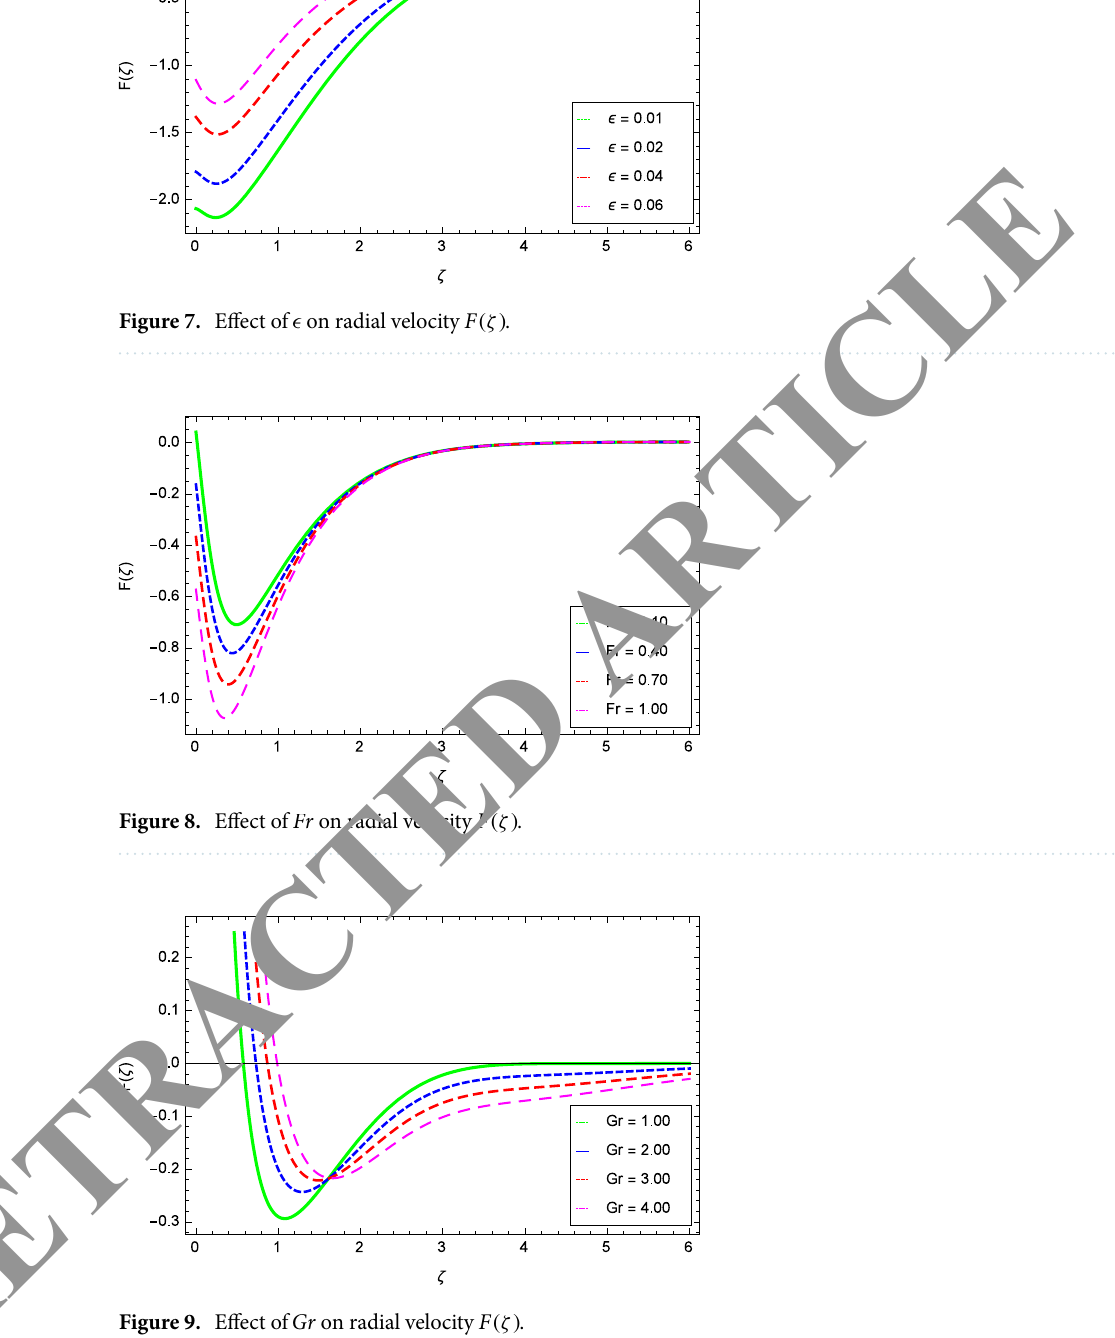
Figure 9. Effect of Gr on radial velocity F (ζ) .